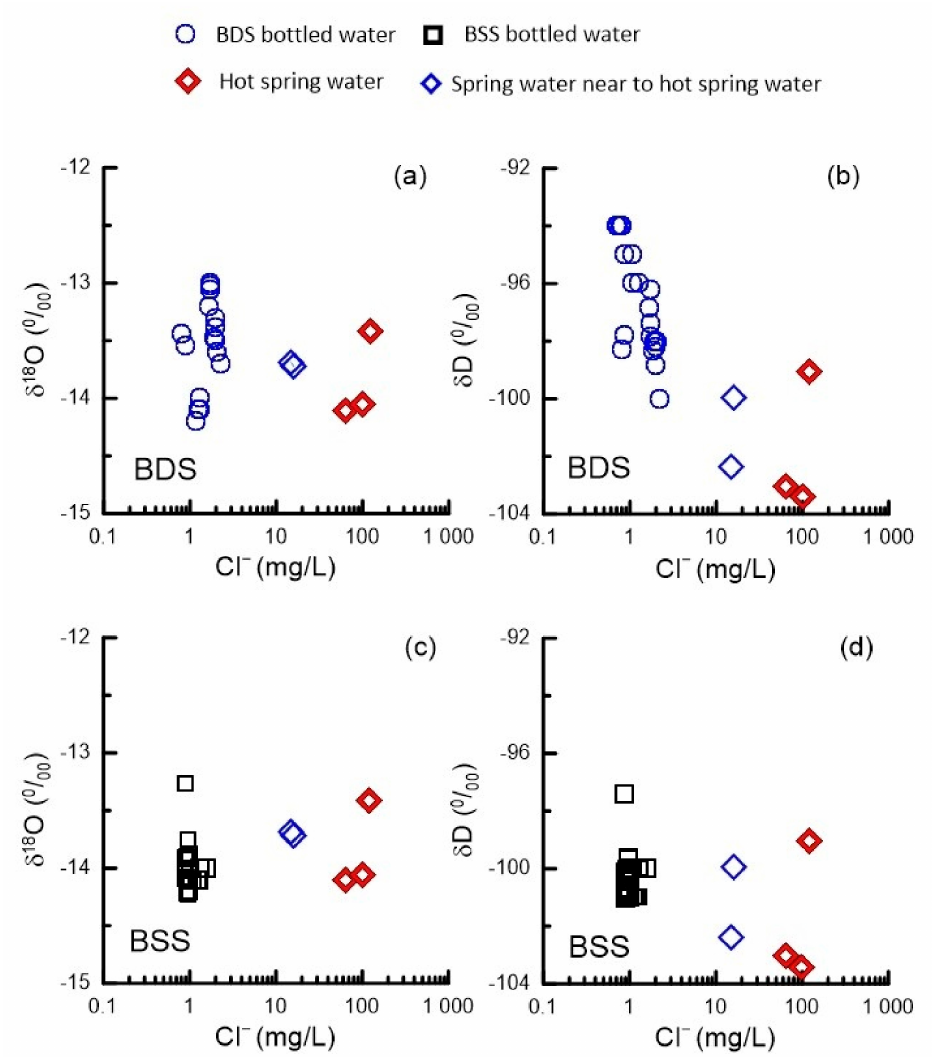
Figure 8. Relationship between chloride and δ 18 O, and δ D in two bottled waters, hot spring and cold spring waters. ( a , b ) are from BDS bottled waters, and ( c , d ) are from BSS bottled waters. 87 Sr/ 86 Sr vs. 1/Sr diagram also indicates that BDS bottled waters was produced from two kinds of aquifers (Figure 9). Lee et al. [46] showed that chemical